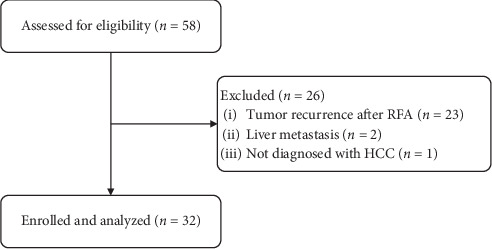
Patient selection.